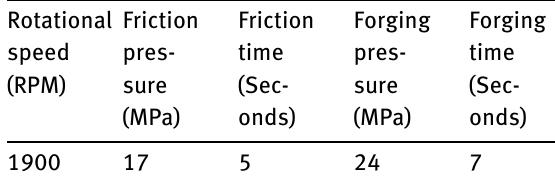
Table 2: Welding parameters used to fabricate the dissimilar joint.